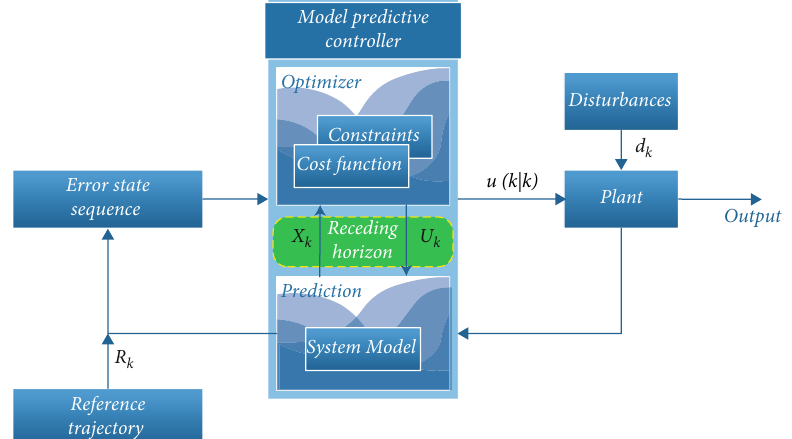
Figure 3: Basic framework of MPC.